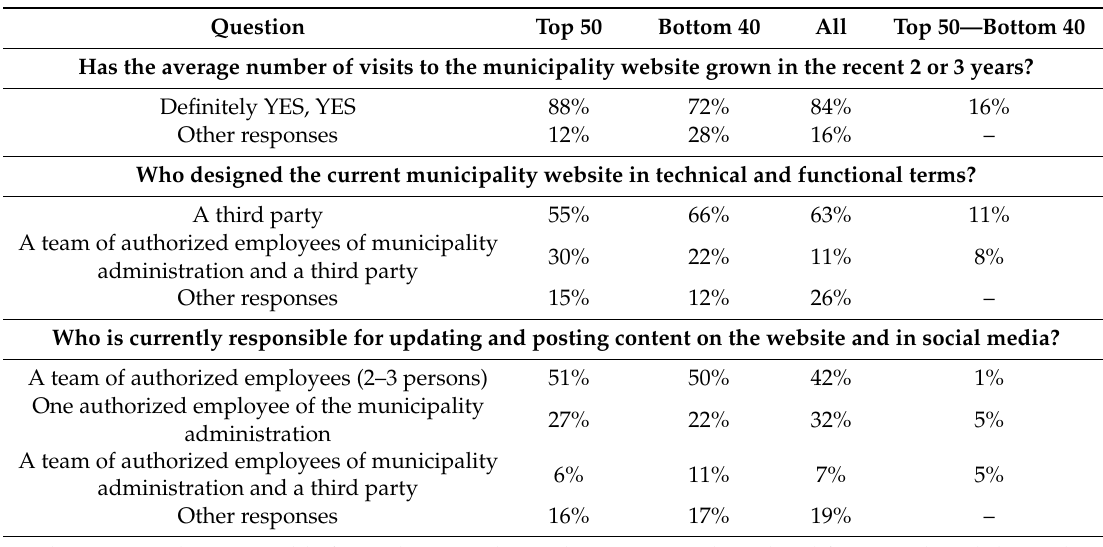
Table 7. Selected results of the questionnaire survey: ‘Initial state analysis’ ( n = 84).